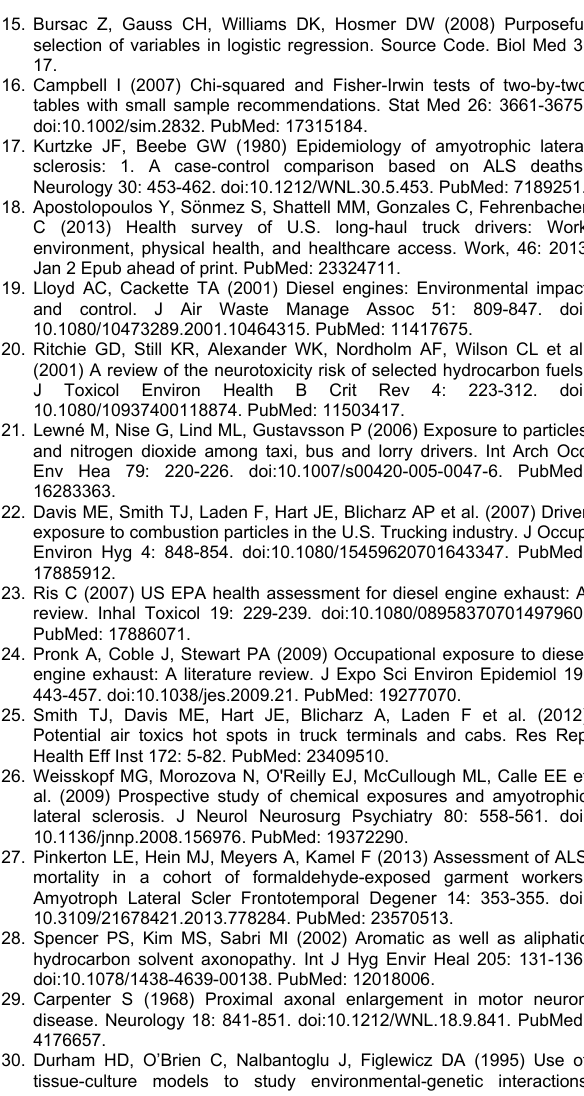
Table S1. Male and female ISCO occupational questionnaire responses.